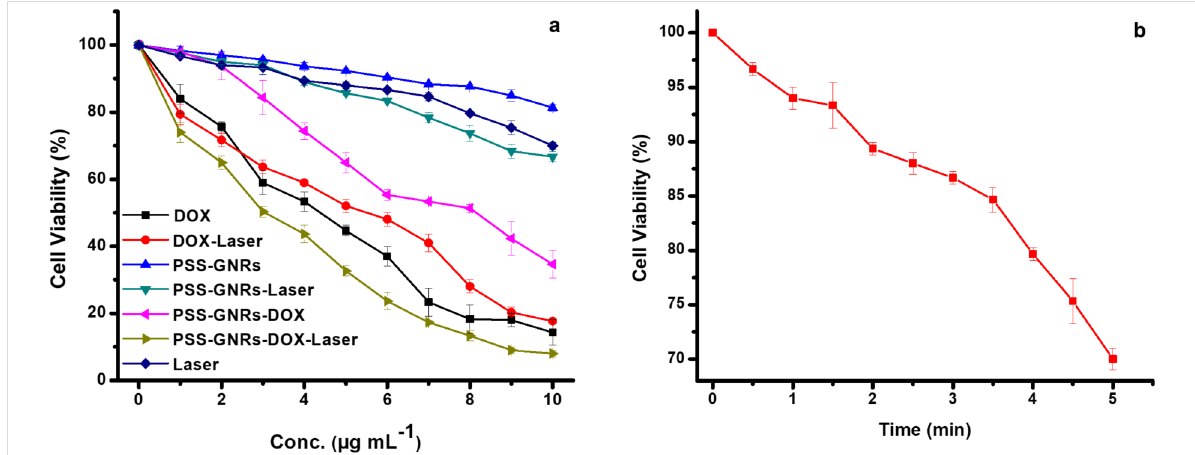
Figure 5: (a) Percentage viabilities of HepG2 cells treated with free DOX and DOX-PSS-GNRs exposed to NIR light (1.5 W/cm 2 for 2 min per treat- ment, three treatments over 2 h). The cytotoxicity values with and without laser irradiation are significantly different with p < 0.05 in the case of DOX- PSS-GNRs according to a two-sample student t -test. (b) Percentage viabilities of HepG2 cells treated with NIR light (1.5 W/cm 2 ) at different points in